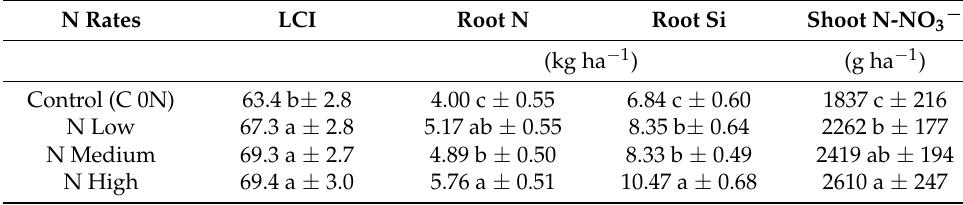
Table 2. Maize leaf chlorophyll index (LCI); root N; root Si accumulation; shoot nitrate (N-NO 3 − ); shoot ammonium (N-NH 4+ ); shoot Si accumulation; shoot biomass and grain yield as a function of N